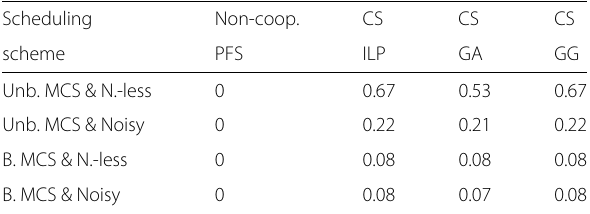
Table 3 Average percentage of muted resources per